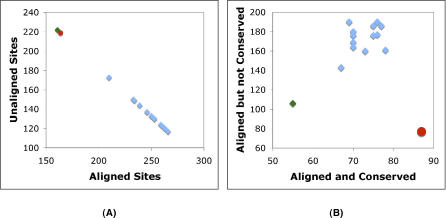
A Total of 383 Binding Sites for the Bicoid Transcription Factor Were Predicted Computationally (Using a Threshold) in D. melanogaster CRMs of the BLASTODERM.A-P Dataset(A) The number of sites that were aligned, versus the number of unaligned sites, using different alignments: Diamonds = LAGAN with varying gap penalties; red circle = Morphalign. (Green diamond represents LAGAN with lowest gap penalty.)(B) Of the sites aligned by a method, how many were conserved (i.e., PWM match score above threshold) in D. mojavensis. Color code is as in (A).